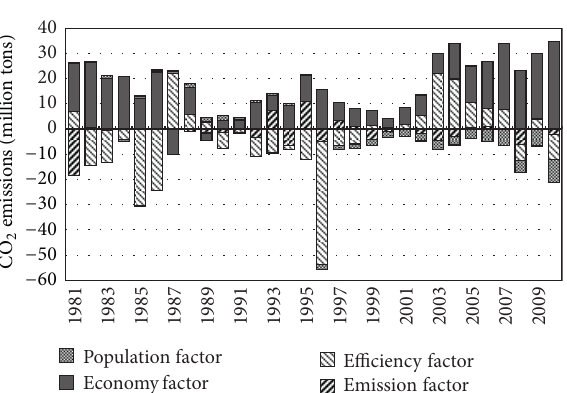
Figure 7: Accumulated CO 2 emissions change of rural residential consumption